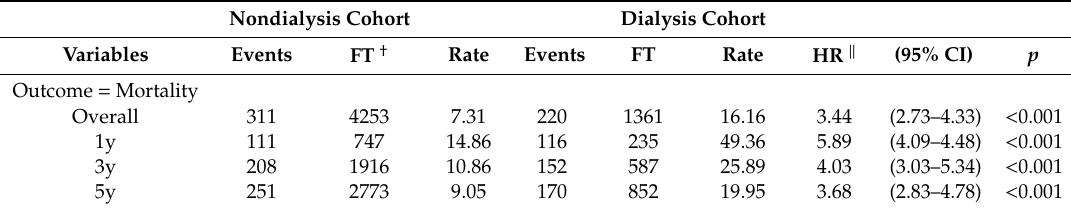
Table 2. Multivariate analysis of mortality between the dialysis and non-dialysis groups.